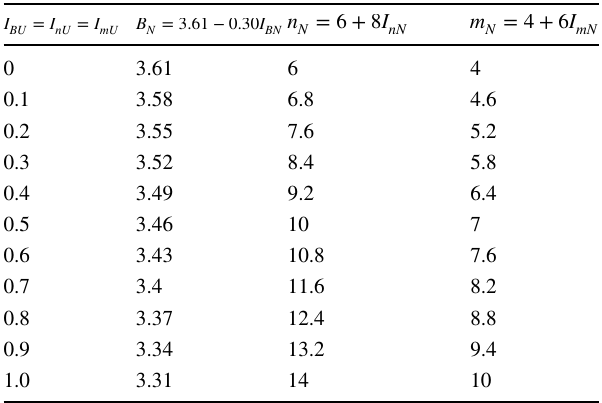
Table 1 Effect of Indeterminacy on sample and